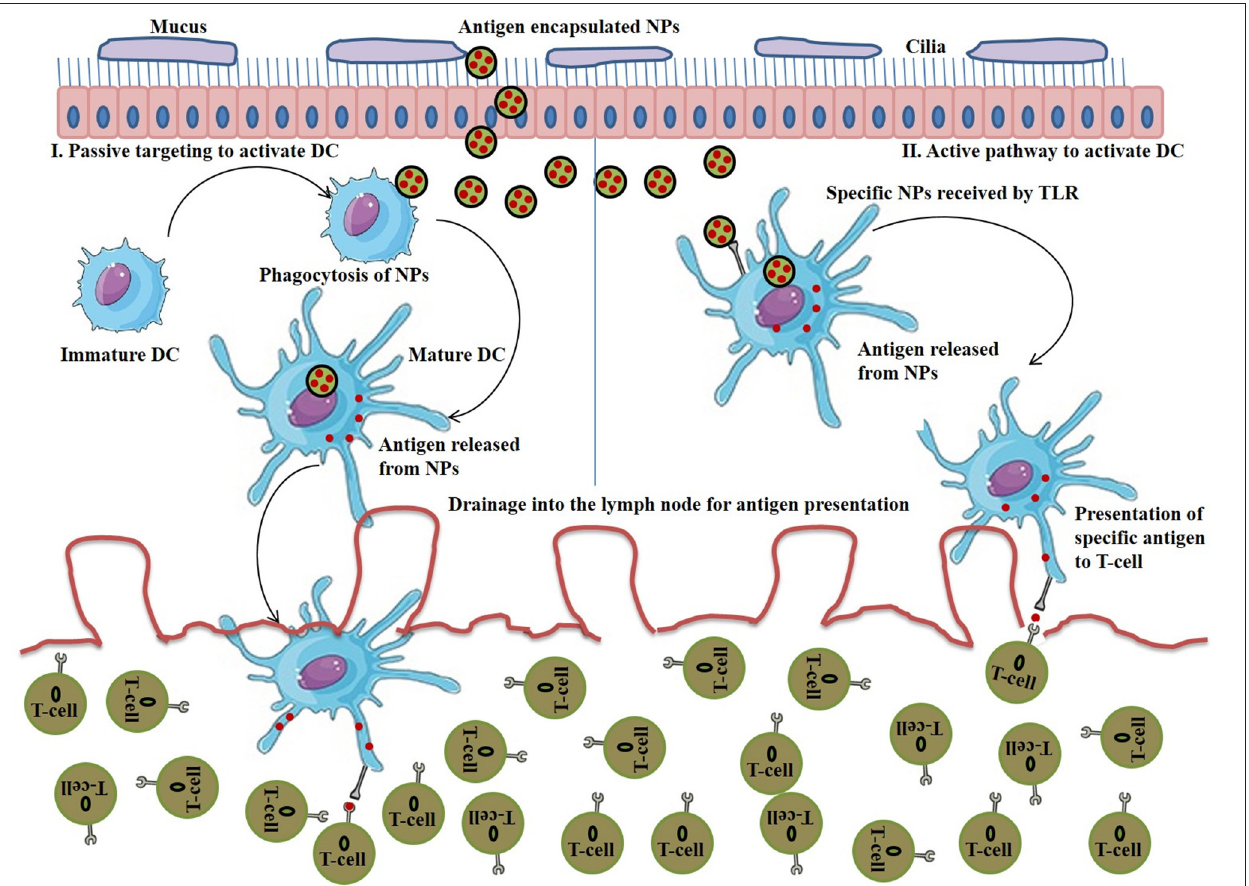
FIGURE 5 | (I) Stimulation of passive pathway to activate DC for cancer immunotherapy by immunostimulatory nanoparticles (NPs), (II) Stimulation of active pathway to activate DC for cancer immunotherapy by immunostimulatory NPs.